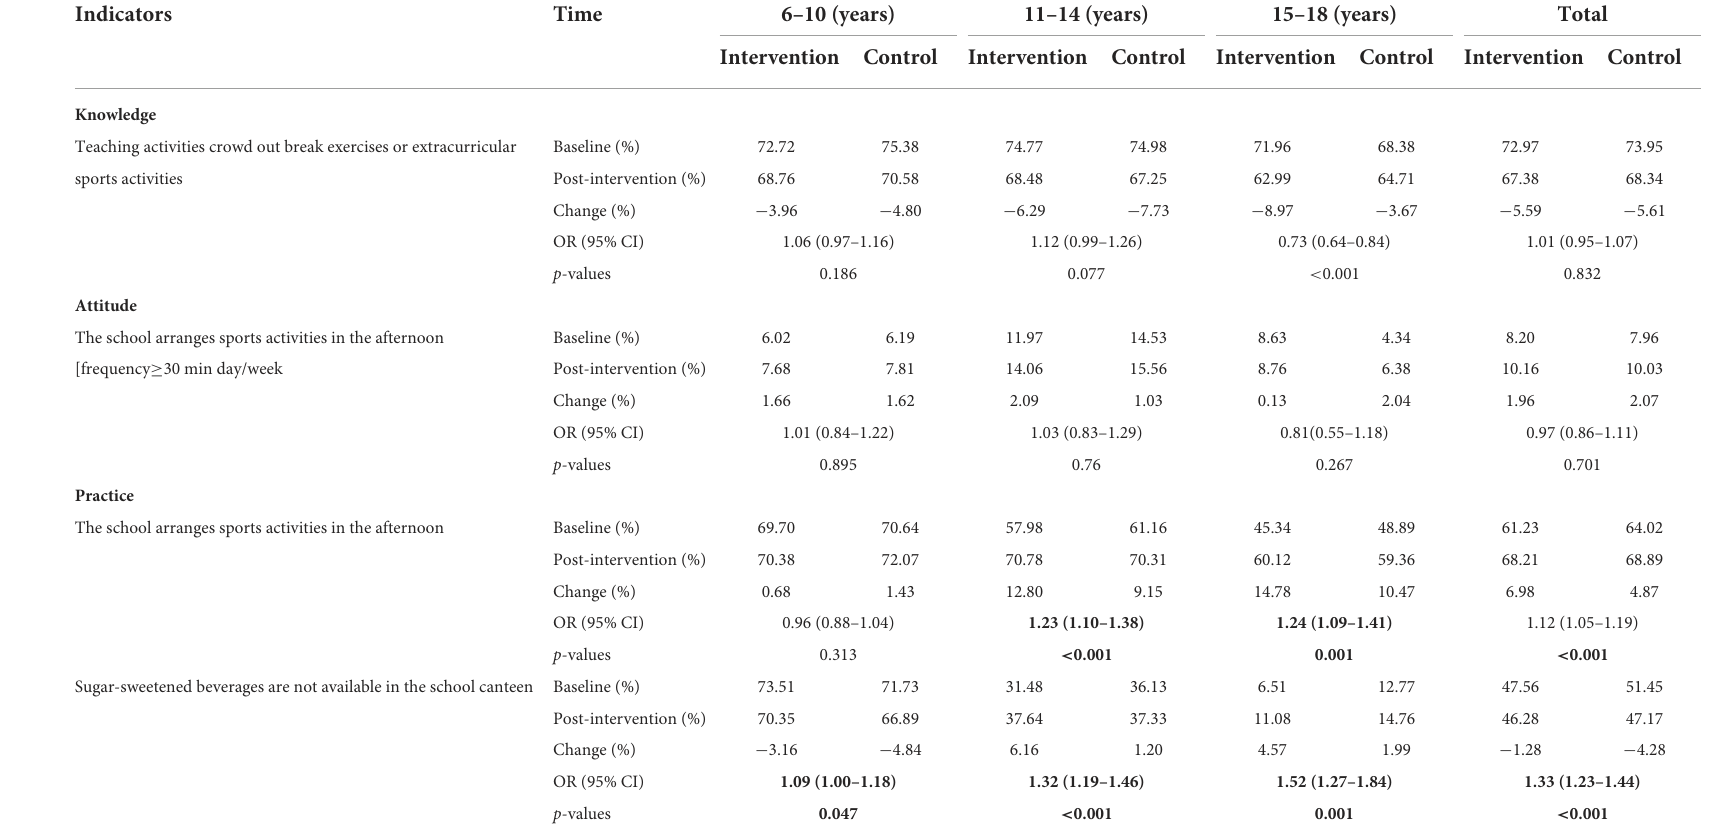
TABLE 7 Effectiveness on the school’s knowledge, belief, and practice (by age).